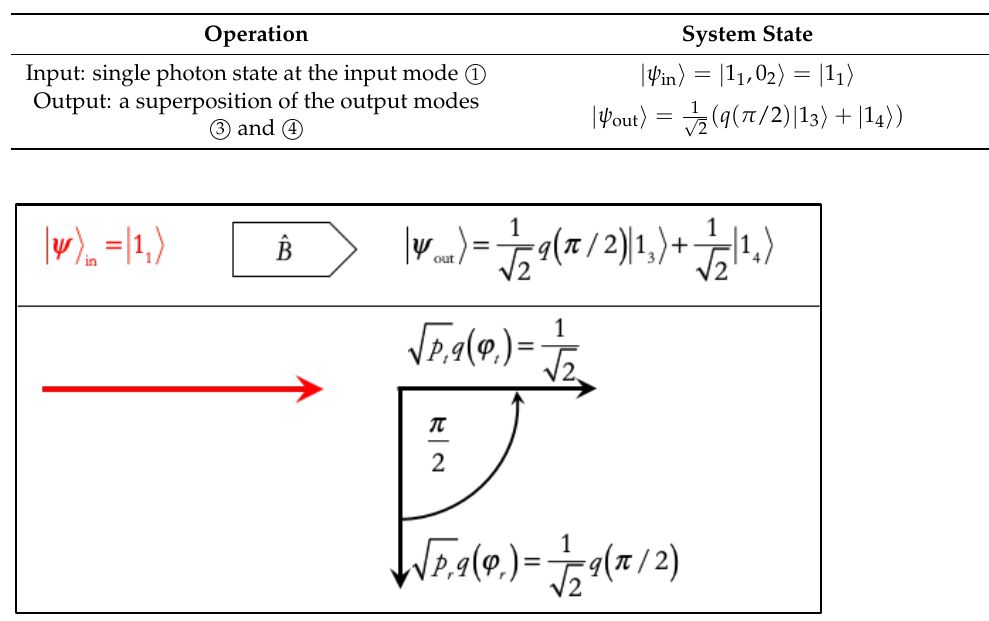
Figure A5. Pointer representation of output state superposition | ψ out (cid:105) ; the transformation | ψ in (cid:105) → | ψ out (cid:105) is mediated by the matrix ˆ B